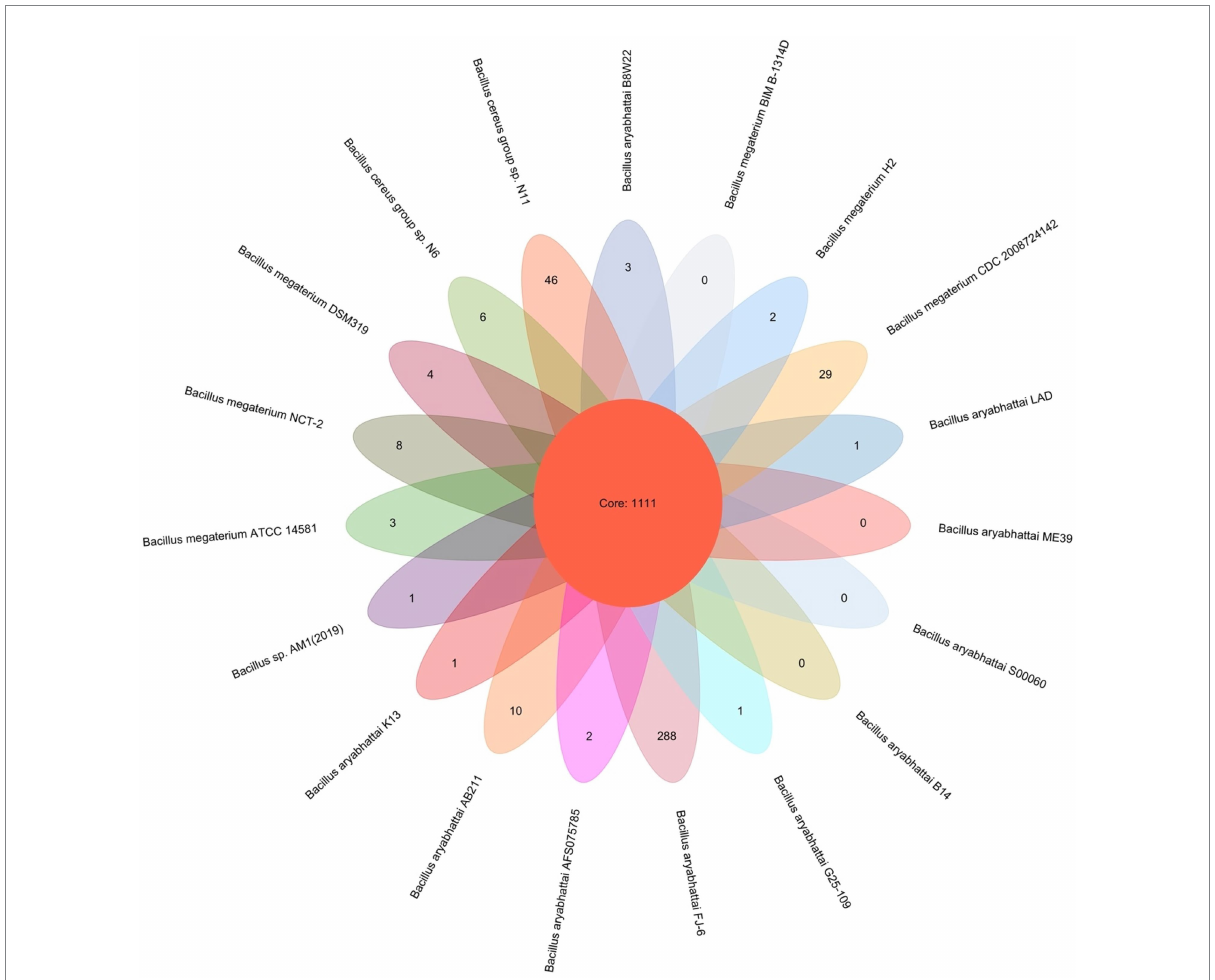
FIGURE 3 Pan-genome analysis of 19 Bacillus strains. The number in the overlapping center represents the number of orthologous coding sequences (core genome) shared by all analyzed strains. The number of coding sequences specific to each strain was shown in the non-overlapping portion of the